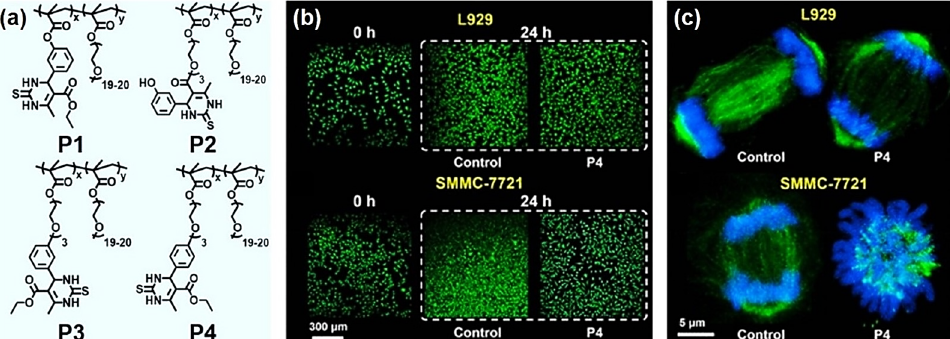
Figure 7. DHPMT-type anticancer polymers produced via the Biginelli reaction. ( a ) The molecular structures of DHPMT-type polymers P1–P4; ( b ) FDA/PI images of L929 ( up ) and SMMC-7721 ( down ) cells incubated with/without P4 (5 mg/mL), 24 h; ( c ) confocal images of L929 ( up ) and SMMC-7721 ( down ) cells incubated with/without P4 (5 mg/mL) using FITC-labeled antibody/Hoechst 33342 for cell staining (green: microtube; blue: chromatin). Reprinted with permission from ref. [61]. Copyright © 2022 American Chemical Society. All rights reserved.